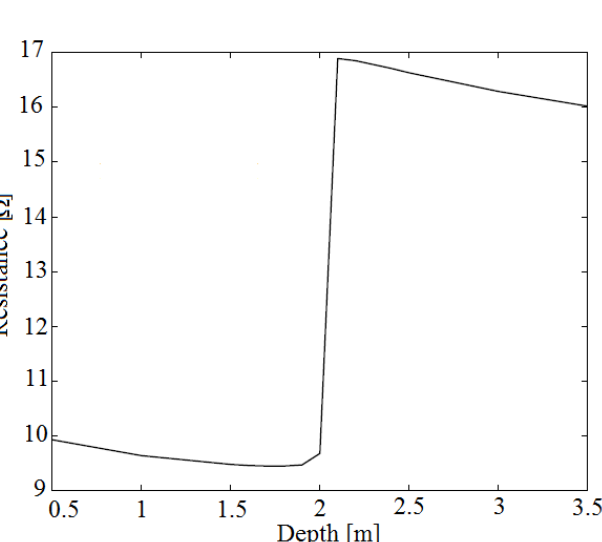
Fig. 12 Resistance ( R g ) versus depth ( D ).